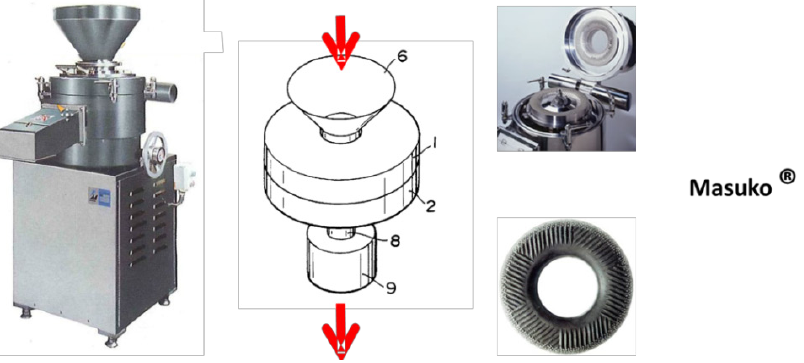
Figure 4. Grinder system developed by Masuko ® for the fibrillation of fiber slurry in order to obtain an NFC